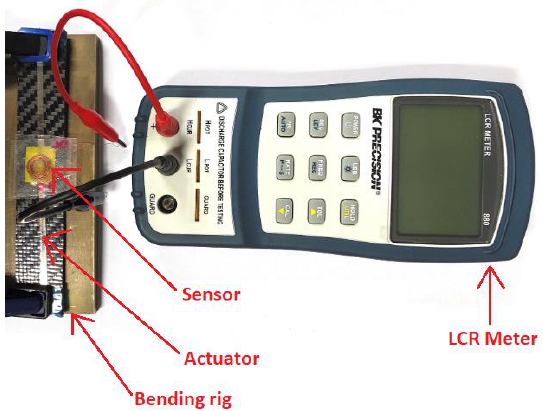
Figure 7. Setup of bending rig test with RLC meter with the main components labelled.